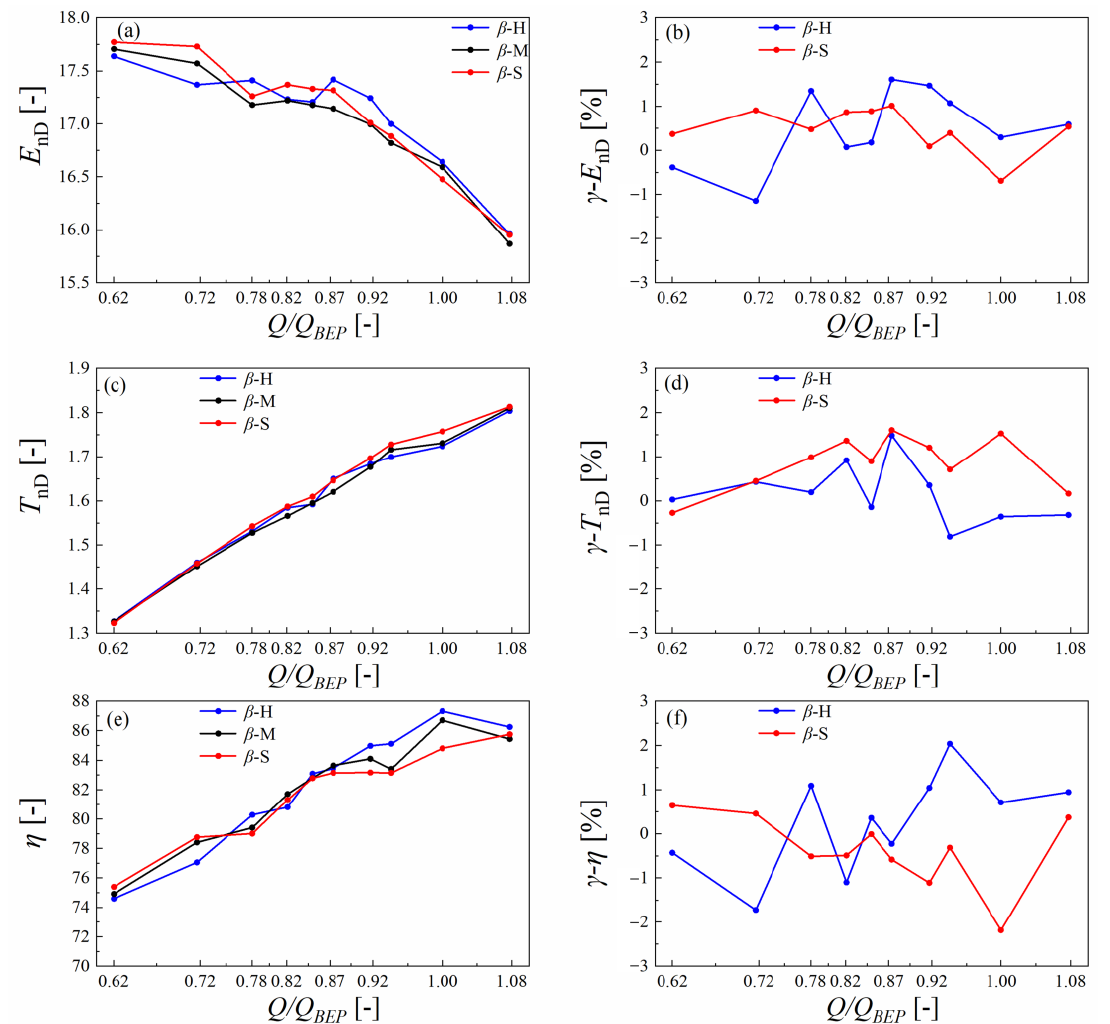
Figure 9. The performance characteristics and relative change rates of various plans: ( a , b ) energy,